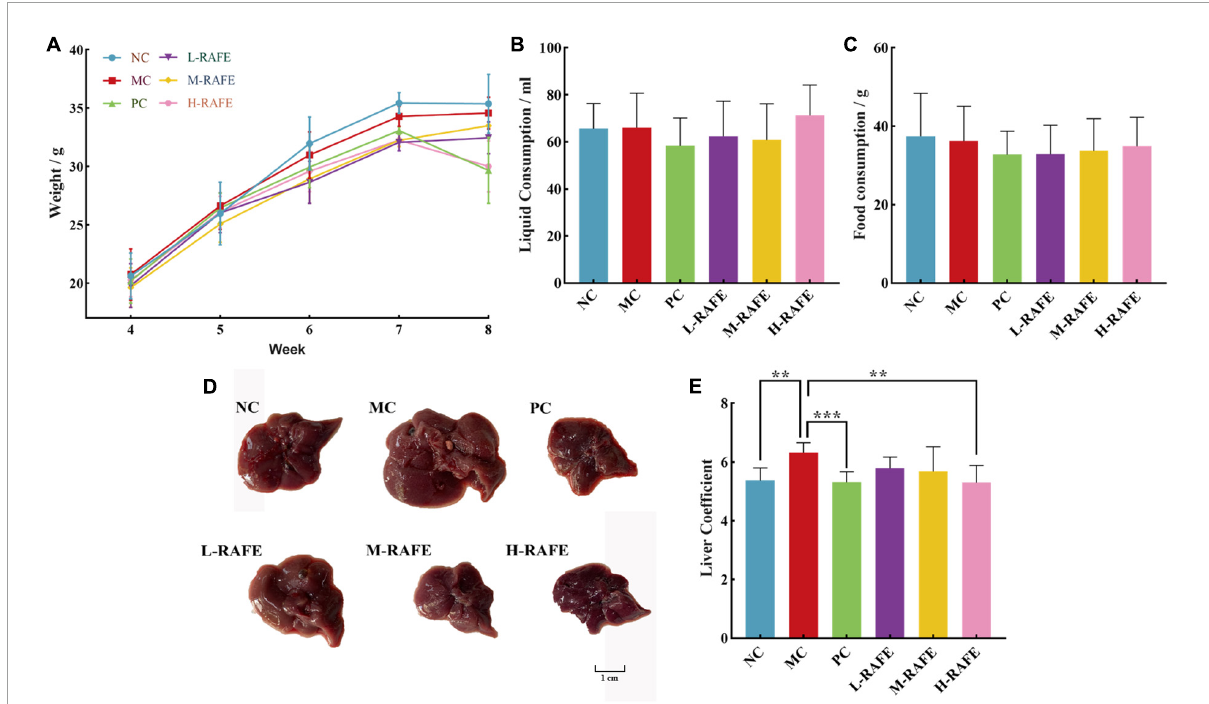
FIGURE3 Effects of RAFE on basic life indicators and livers of mice. (A) Weekly body weight, (B) weekly fluid consumption, (C) weekly food consumption, (D) morphological observation, and (E) liver coefficient. Data are expressed as the mean ± SD ( n = 4 or 6) ** P < 0.01, *** P < 0.001, compared with the pathology group.